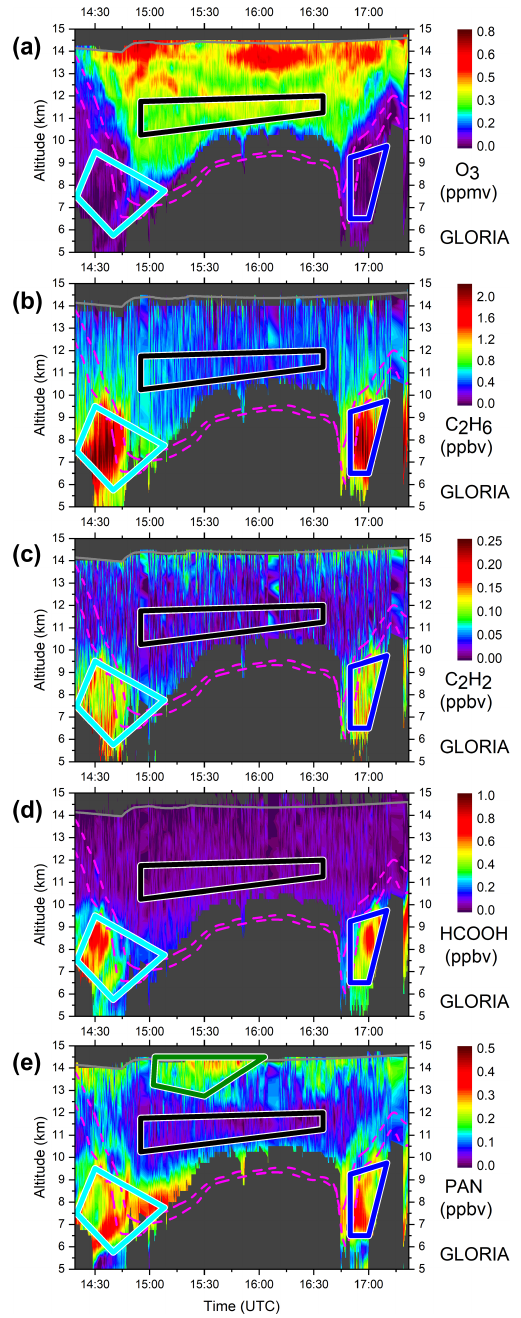
Figure 6. Horizontal and vertical VMR distributions of (a) O 3 , (b) C 2 H 6 , (c) C 2 H 2 , (d) HCOOH, (e) PAN as seen by GLORIA above the North Atlantic region on 13 September 2017. Flight alti- tude is shown as grey line; dynamical tropopause (2 and 4 potential vorticity units from ECMWF) is plotted as dashed magenta lines. Cyan, blue, and green (only PAN) boxes mark regions with en- hanced VMR levels (for pollutant species not for O 3 ); black boxes comprise a region with low mixing ratios. For all these boxes, back- ward trajectories are calculated (see discussion in Sect.